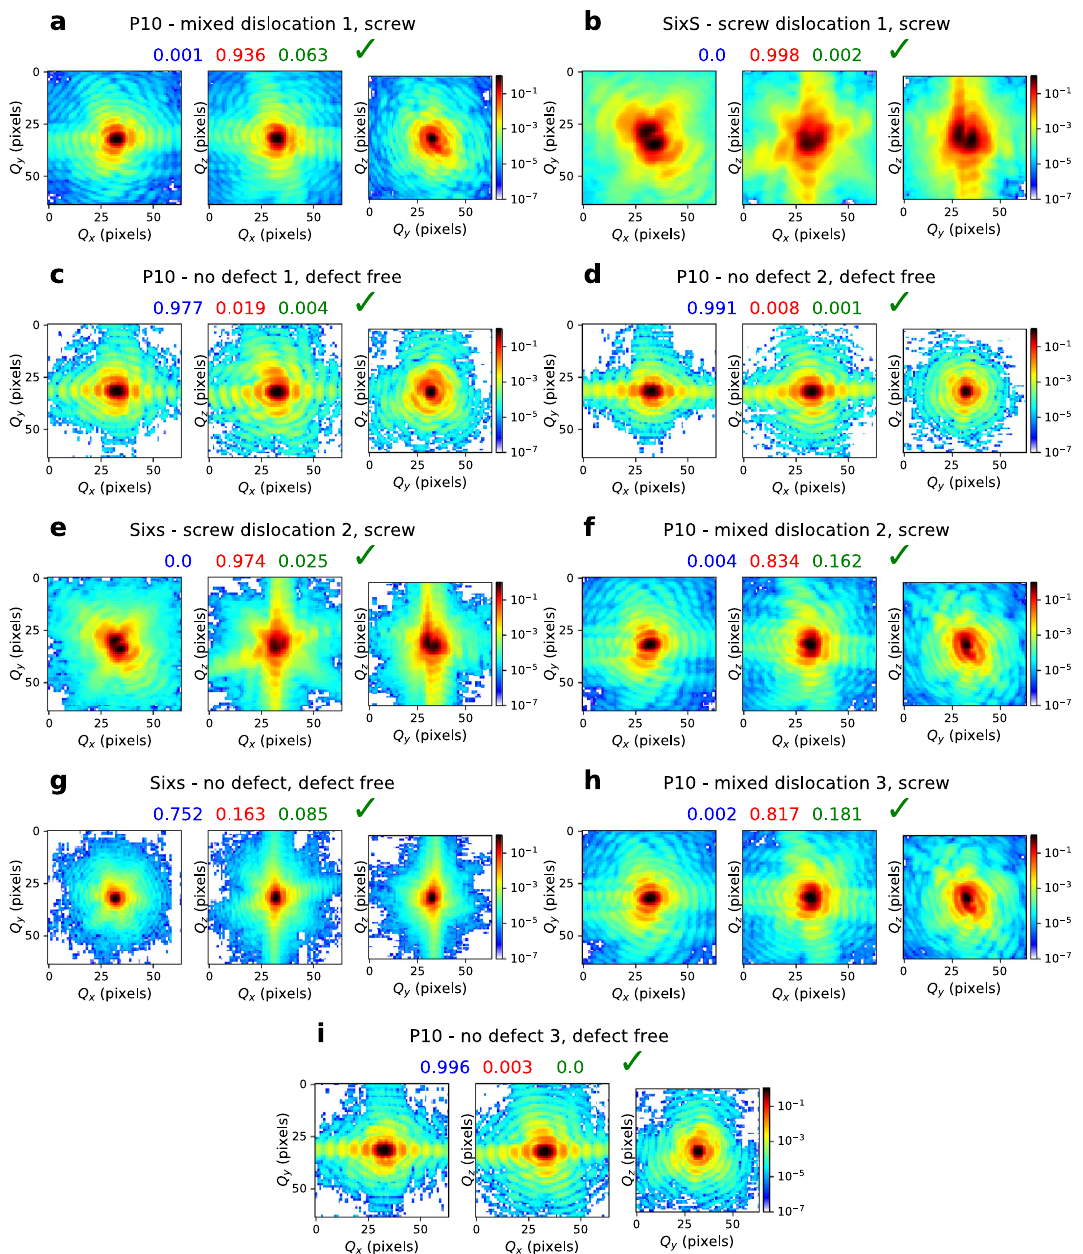
Fig. 4 Predictions from the best model on experimental data. For each example, the probabilities for the 3 classes are shown in the title where blue, red, and green correspond respectively to defect-free, screw, and edge class. Three cross-sections of the 3D CXDP are shown for each example. Using this NN model, all examples are correctly predicted (see green ticks). The CXDPs are on a logarithmic scale to enhance the fringes